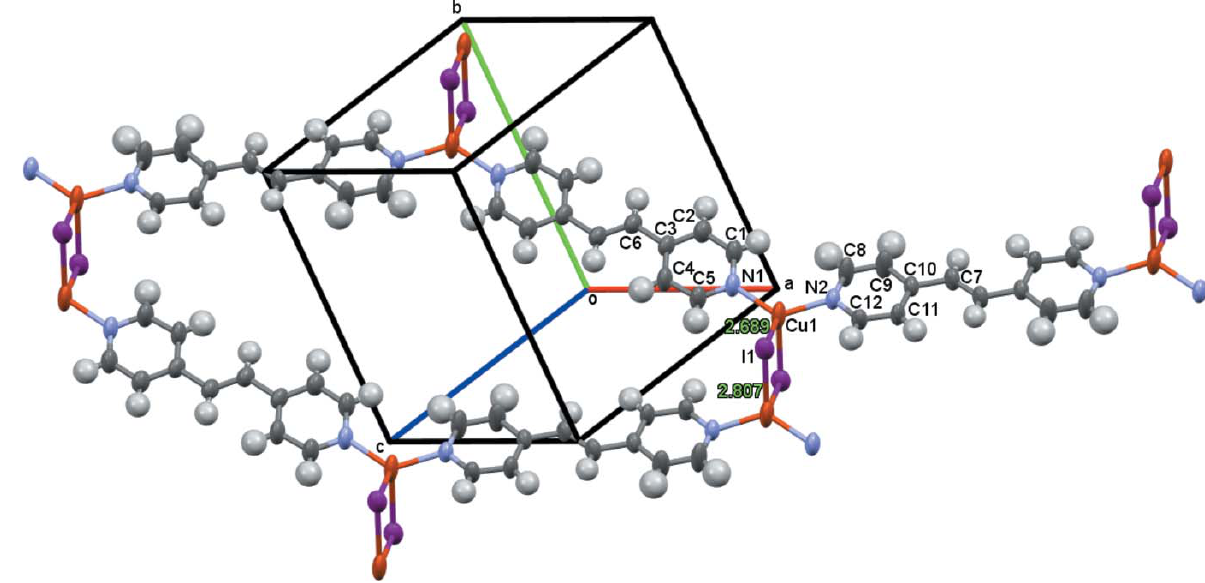
Figure 1 Displacement ellipsoid plot (50% probability level) of all non-H atoms for the oligomeric ribbons of Cu 2 I 2 dimers bridged by bpe and arranged as stairsteps with 2.8072 (11) A˚ height (the Cu—I i distance). Cu—I and Cu—I i distances are shown. Guest bpe molecule are omitted for